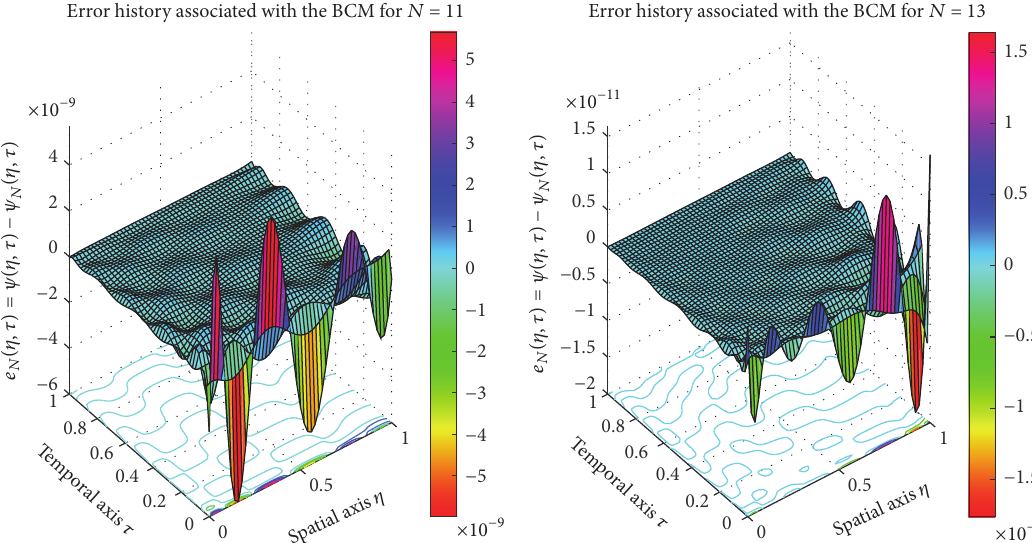
Figure 6: Error histories associated with the obtained numerical solution of the first example for 𝑁 = 11, 13 .